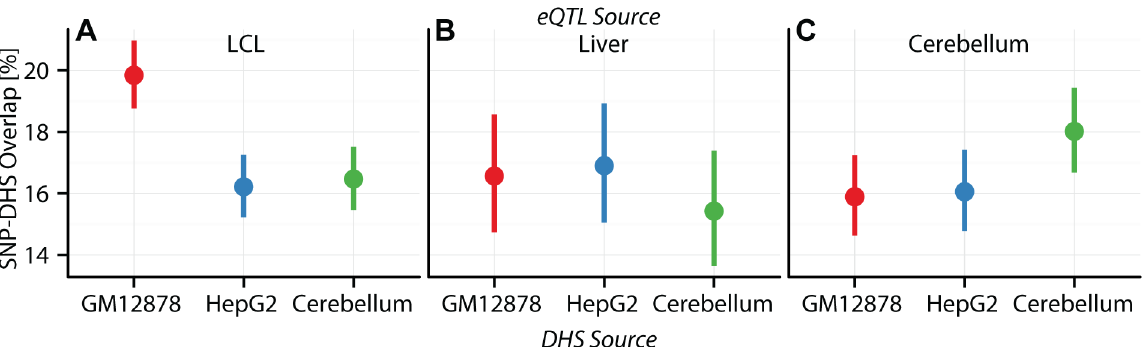
Figure 5. Cell specificity of eQTL SNP-CRE overlap illustrated with DNAse hypersensitivity data. Percentage (dots) and 95% confidence interval (lines) of (A) CAP_LCL, (B) UChicago_liver, and (C) Harvard_cerebellum eQTL SNPs overlapping DHS sites (y-axis) derived from the LCL cell line GM12878 (red), the HepG2 cell line (blue), and the cerebellum (green).